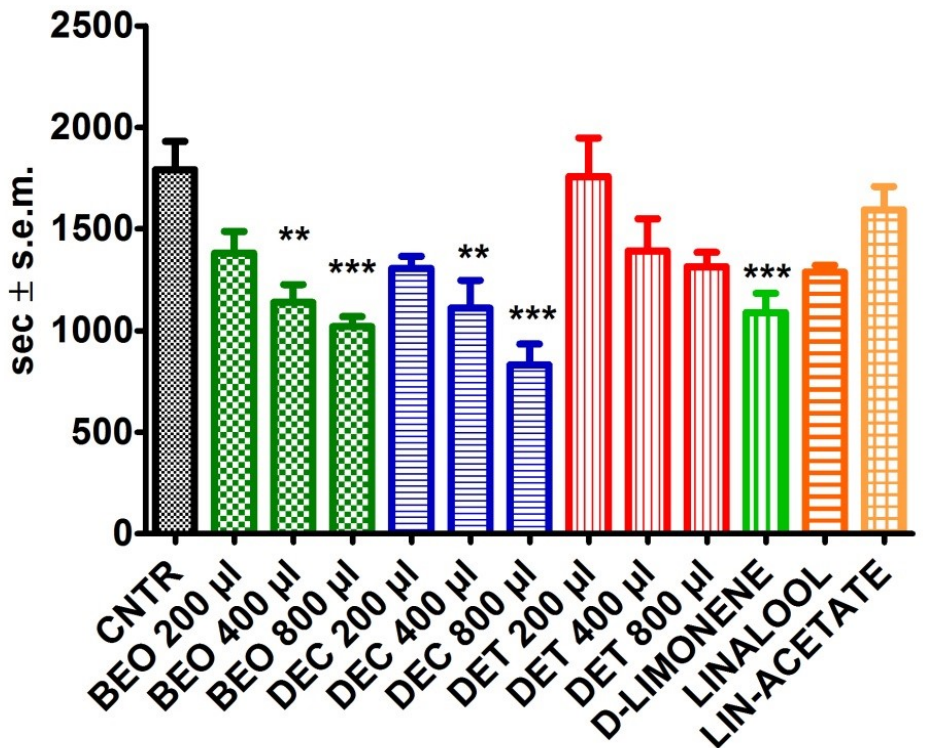
Figure 3. Effects of bergamot essential oil (BEO), of the decolored (DEC) and deterpenated (DET) fractions, and of D-limonene, linalool, and linalyl acetate (expressed in seconds (sec)) on locomotor activity after one hour of observation. One-way ANOVA followed by Bonferroni test; n = 8, * p < 0.05, ** p < 0.01, *** p < 0.001.